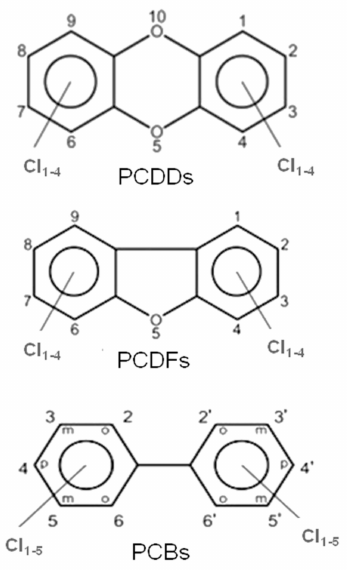
Figure 1. General molecular structures of chlorinated dioxins (PCDDs), furans (PCDFs) and biphenyls